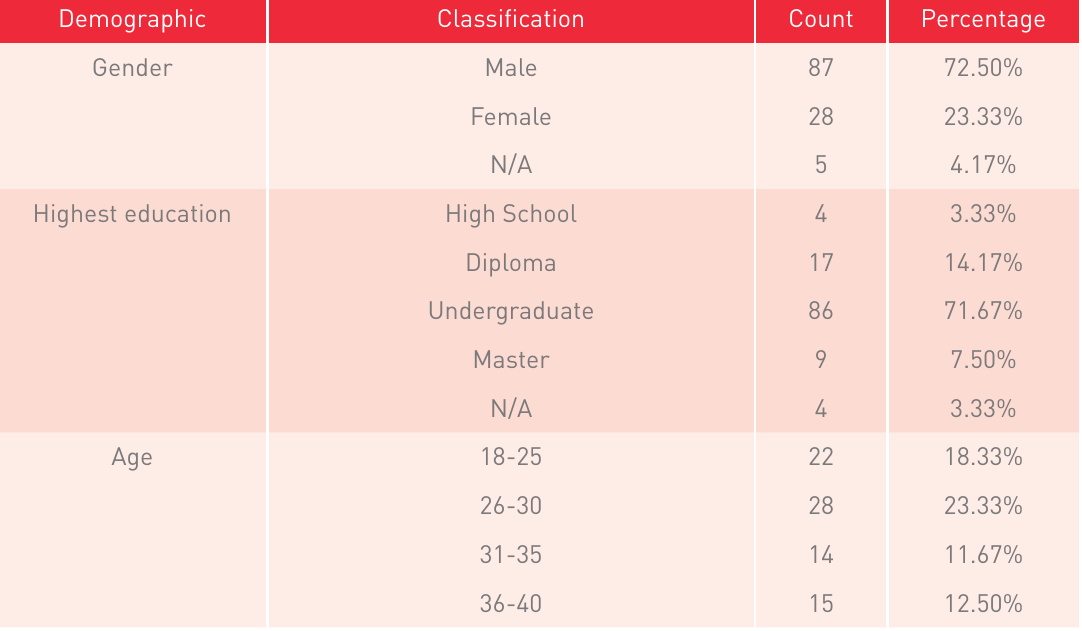
Table 4. Demographic profile of the